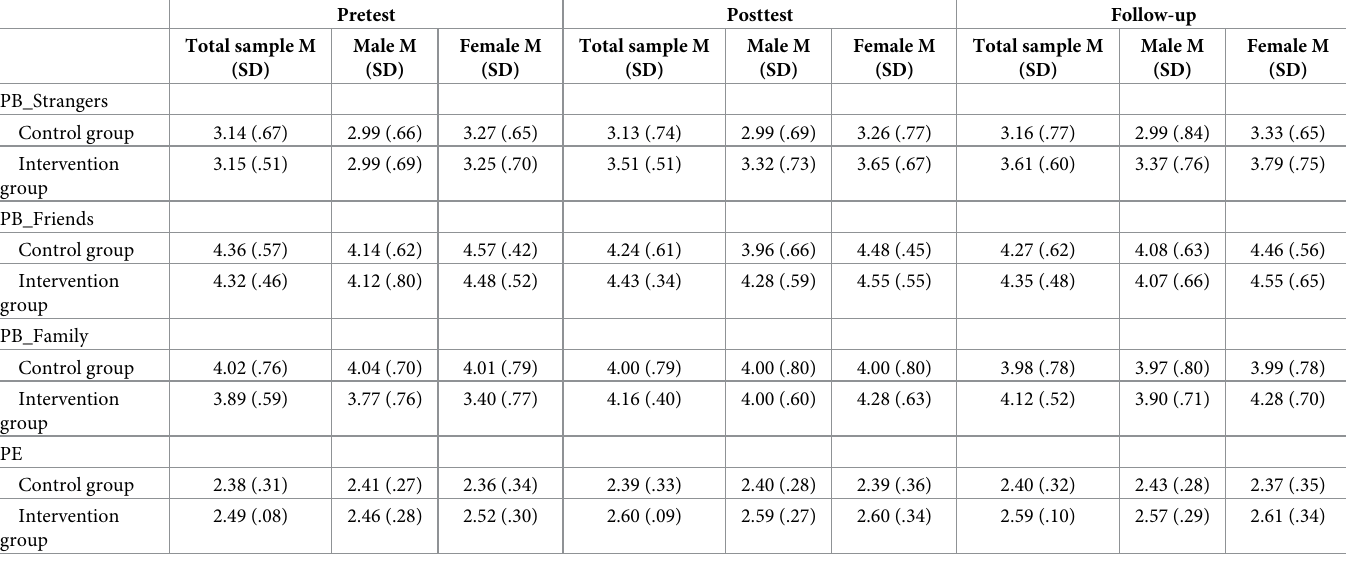
Table 1. Mean and standard deviation of the variables. Pretest Posttest